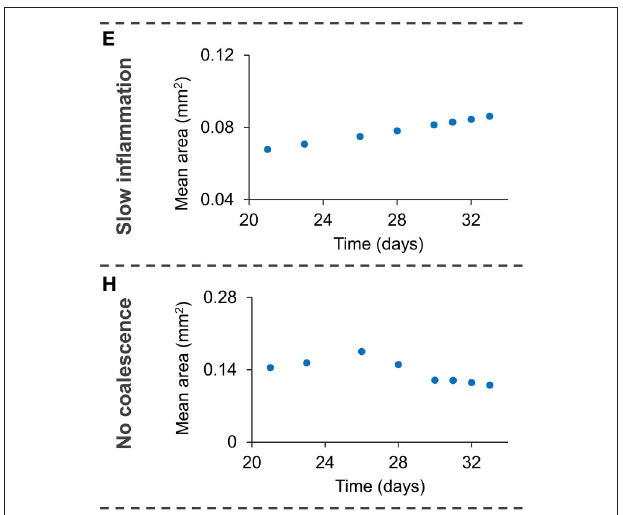
FIGURE 7 | Enlargement of Figures 6E,H, showing the small increase in mean are with a small inflammatory response (E) and with no coalescence